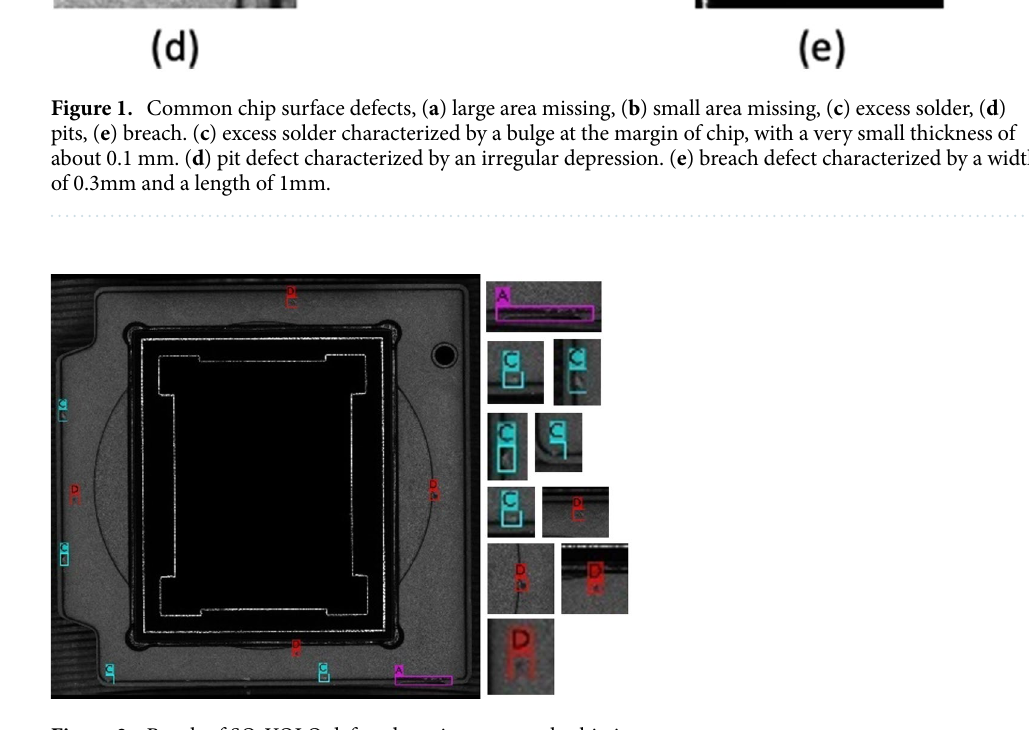
Figure 2. Result of SO-YOLO defect detection on sample chip